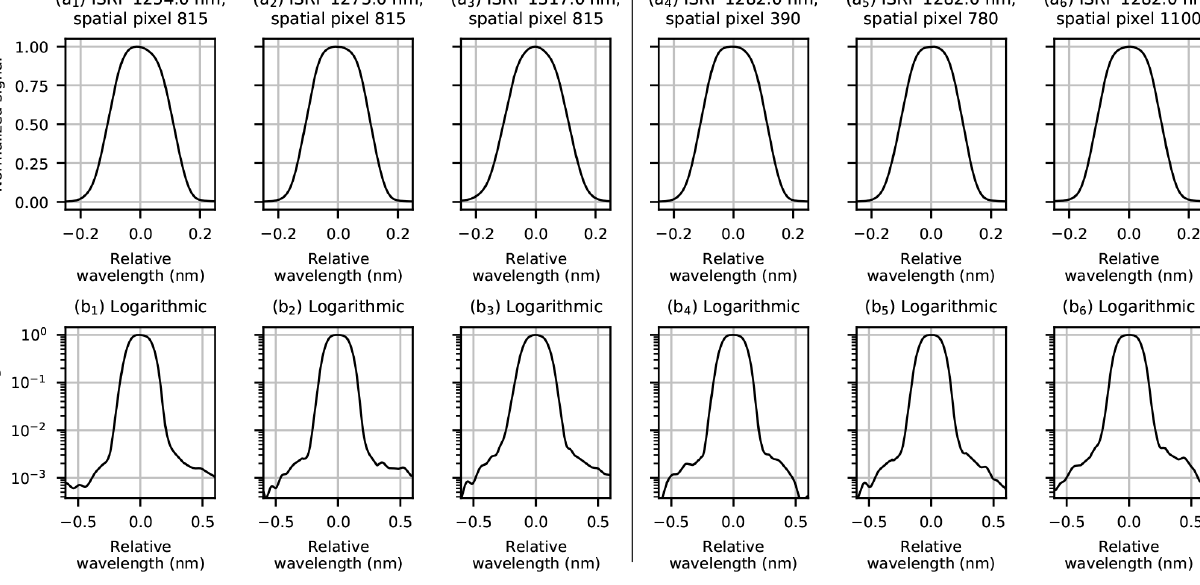
between the measured points. As shown by the bottom panels of Fig. 16, the residuals for various polynomial degrees are quite similar, and less than approximately 0.02 spectral